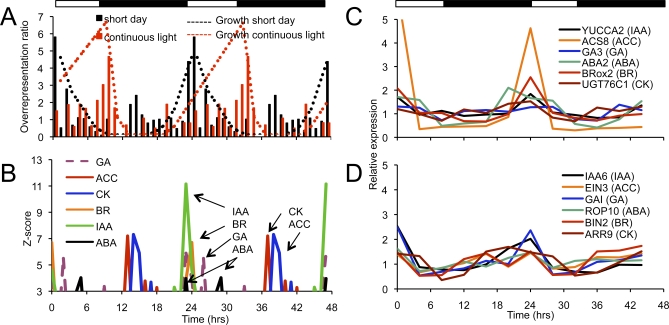
Phytohormone Transcript Abundance Correlates with Time of Hypocotyl Growth under Short-Day Photocycles and Continuous Light(A) Phytohormone genes display peak transcript overrepresentation during the phase of peak growth. Peak growth rate under short-day photocycles (black dashed lines) and continuous light (red dashed lines) reproduced from [15–17] correlates with peak transcript overrepresentation under short-day photocycles (black bars) and continuous light (red bars).(B) Z-score significance score for individual groups of phytohormone genes under short day. Data generated using PHASER. Z-score = 3, approximately p = 0.01. GA (dashed brown), ACC (red), CK (blue), BR (orange), IAA (green), and ABA (black).(C) Phytohormone biosynthesis transcripts show peak abundance during the growth phase under short-day photocycles.(D) Phytohormone signaling transcripts show peak abundance during the growth phase under short-day photocycles.Data in (A) and (B) are double plotted for visualization purposes; 1 d (24 h) of data copied and graphed a second day to allow visual continuity of the time-of-day data. Gene names in (C) and (D) are indicated, and the phytohormone pathway is in parentheses.